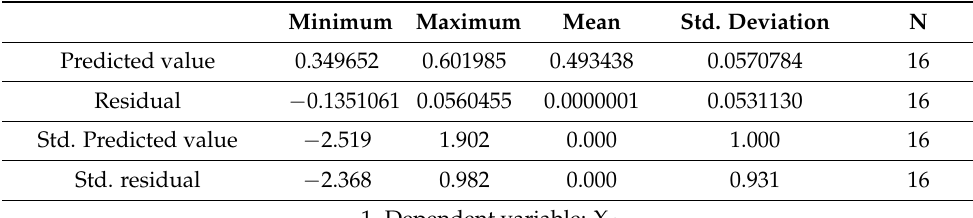
Table 14. Statistics-residuals with two